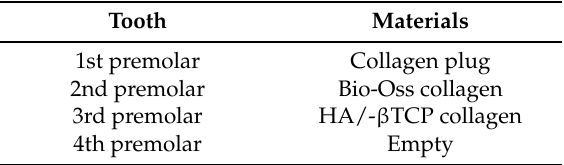
Table 3. Study design for the beagle’s extraction socket. Different materials were placed into the different tooth extraction sockets. The control socket was empty.